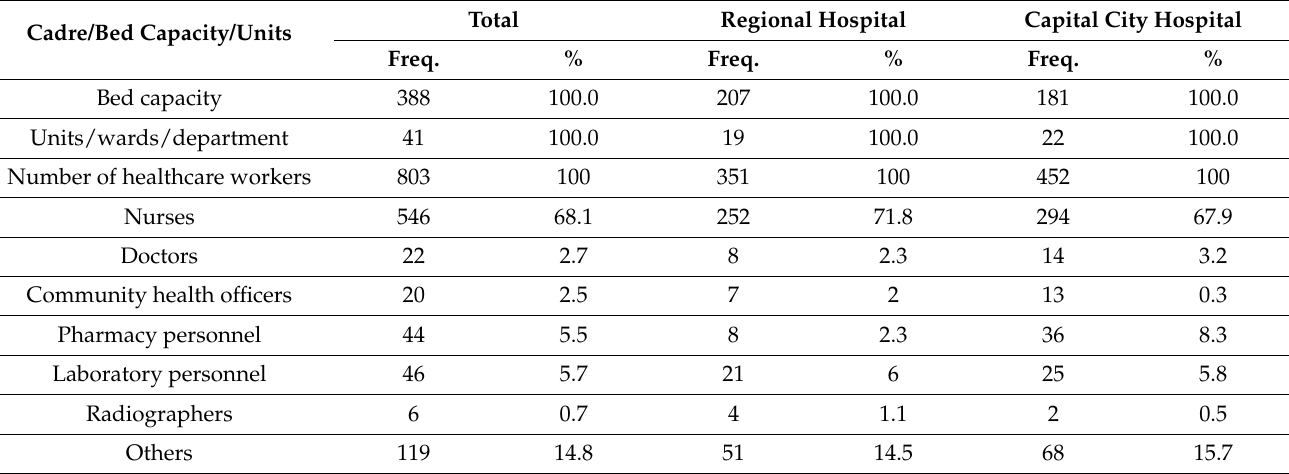
Table 1. Healthcare workers in the provincial and capital city hospitals in Sierra Leone. Cadre/Bed Capacity/Units